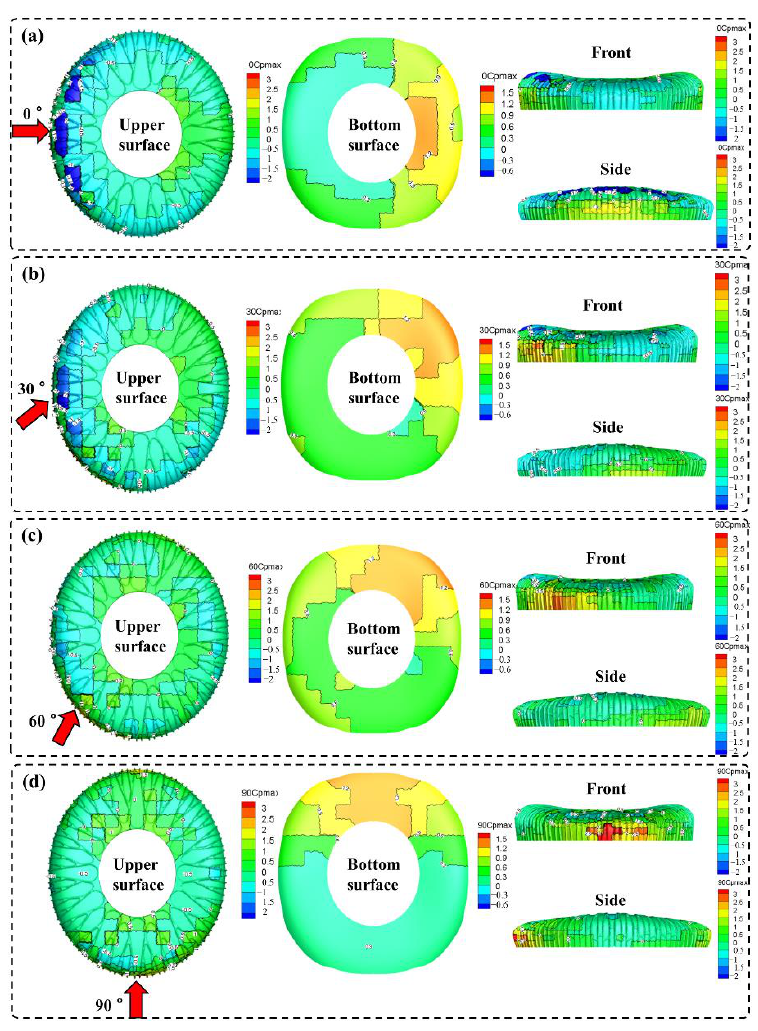
Figure 15. Maximum value of wind pressure coefficient at each wind direction angle for working case 1: ( a ) 0°; ( b ) 30°; ( c ) 60°; ( d ) 90°. case 1: ( a ) 0 ◦ ; ( b ) 30 ◦ ; ( c ) 60 ◦ ; ( d ) 90 ◦